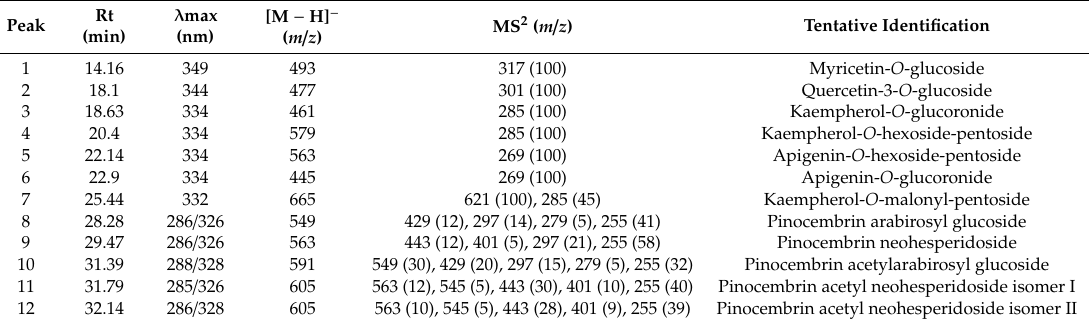
Table 7. Retention time (Rt), wavelengths of maximum absorption in the visible region ( λ max), mass spectral data, and tentative identification of the phenolic compounds present in the hydroethanolic extracts of Centaurea raphanina subsp. mixta plants grown in 2 L pots under greenhouse